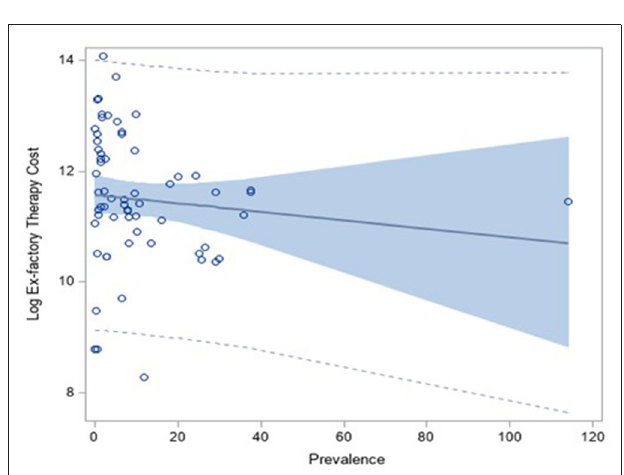
FIGURE 2 | Correlation analysis between the log of the annual therapy cost (calculated on the ex-factory price) and the prevalence of the disease.